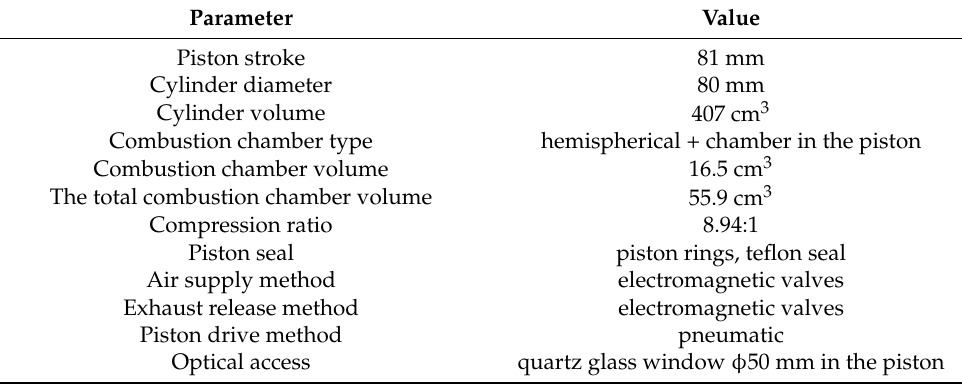
Table 4. Technical data for the rapid compression machine used for the combustion tests.